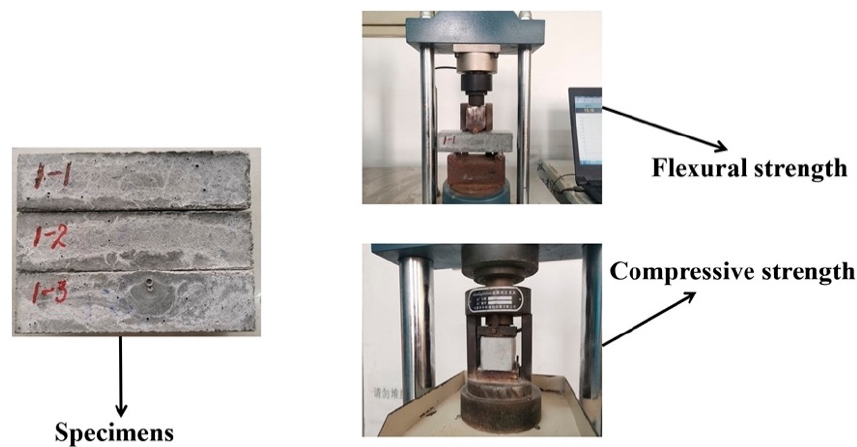
Figure 2. The flexural and compressive strengths of RPC.